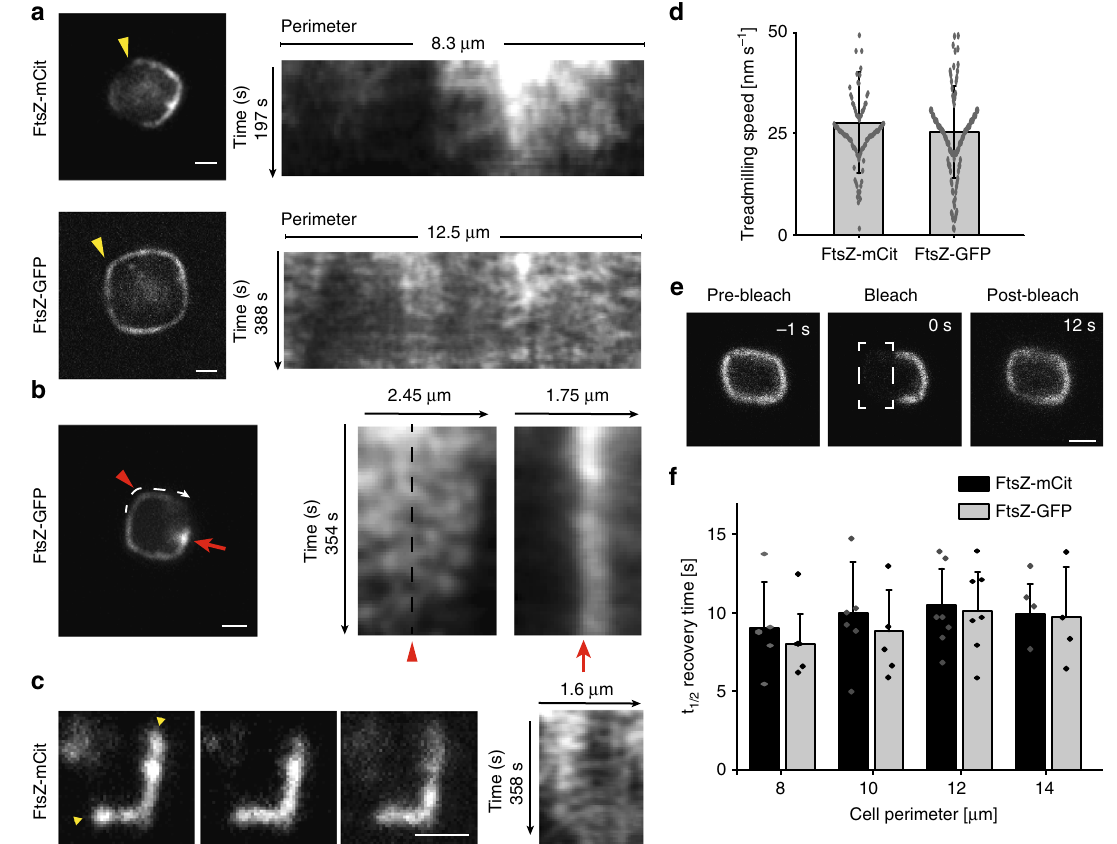
Fig. 4 FtsZ dynamics in rectangular-shaped cells. The dynamics of FtsZ in rectangular shapes were assessed by time-lapse imaging and FRAP measurements on E. coli cells expressing FtsZ-mCitrine (FtsZ-mCit) or FtsZ-GFP. a – c Snapshot images from time-lapse series of FtsZ-mCitrine or FtsZ-GFP in rectangular shaped cells. Corresponding kymographs are shown next to each image. a Kymographs were taken around the entire perimeter (starting at the upper left corner, moving counter-clockwise, indicated by the yellow arrowheads). b Kymographs were taken along the white line (left kymograph), or over the bright spot indicated by the red arrow (right kymograph). FtsZ can clearly be seen treadmilling continuously across the sharp corner (indicated by the red arrowhead). The red arrows and arrowheads in the images correspond to the arrows and arrowheads on the kymographs. The black dashed line in b indicates the upper left corner of the cell. c Kymograph taken between the yellow arrowheads (top to bottom is left to right in the kymograph). d Average treadmilling speed of FtsZ-mCitrine and FtsZ-GFP in rectangles was 27.6 ± 12.5 nm s − 1 ( n = 97) and 25.3 ± 11.3 nm s − 1 ( n = 122), respectively. e Typical FRAP measurement of FtsZ-GFP in a rectangular E. coli cell. Half of the rectangle was bleached. f Average recovery times for FtsZ-mCitrine (dark, n tot = 24) and FtsZ-GFP (light, n tot = 22) in FtsZ-rectangles of various perimeter lengths. FRAP recovery times for rectangular cells with different perimeters: FtsZ- mCitrine t 1/2 recovery times: 9 ± 2.9 s (Circ. 8 ± 1 μ m, n = 6), 10 ± 3.2 s (Circ. 10 ± 1 μ m, n = 7), 10.4 ± 2.3 s (Circ. 12 ± 1 μ m, n = 7), 9.9 ± 1.9 s (Circ. 14 ± 1 μ m, n = 4). FtsZ-GFP t μ m, n = 5), 8.8 ± 2.6 s (Circ. 10 ± 1 μ m, n = 5), 10.1 ± 2.5 s (Circ. 12 ± 1 μ m, n = 8), 9.7 ± 3.2 s 1/2 recovery times: 8.1 ± 1.9 s (Circ. 8 ± 1 (Circ. 14 ± 1 μ m, n = 4). Circ. = Cell circumference. Values represent mean ± S.D. Dots represent individual data points, bars represent mean with error bars representing S.D. Scale bars = 1 μ